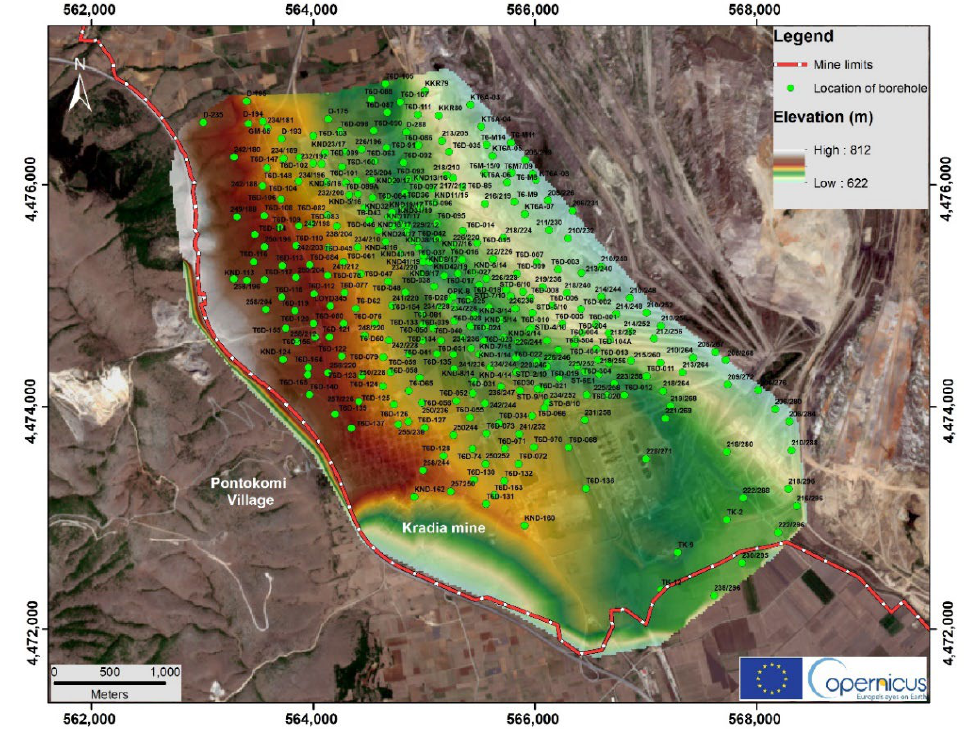
Figure 3. The map represents the spatial location of the analyzed boreholes (304) combined with the Digital Elevation Model in the study area using ArcGIS 10.4 version. The base map is provided by Sentinel 2b satellite European Union—Copernicus program) with sensing date: 31 August 2021.